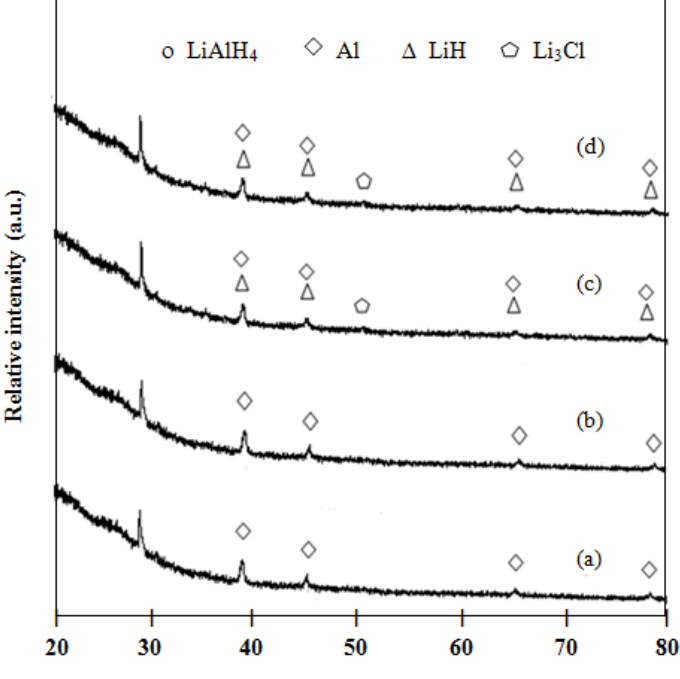
Figure 6. XRD patterns of: ( a ) milled 3 mol % TiCl –2LiAlH TiCl 3 TiCl –2LiAlH 3